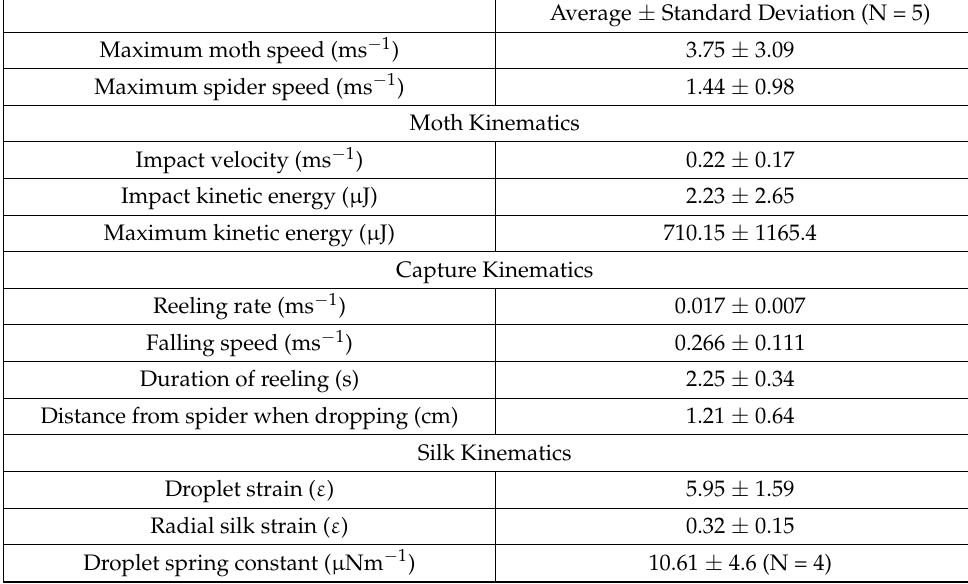
Table 1. Kinematics of spider, moth, and bolas during prey